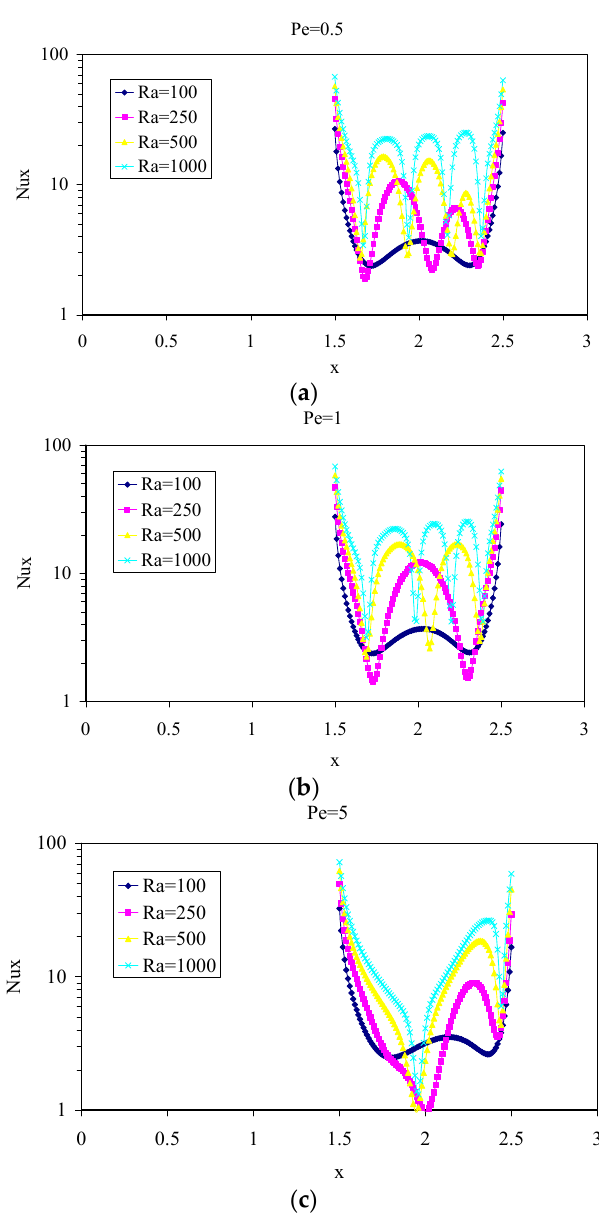
Figure 7 Variation of local Nusselt number along the channel ( c = 0.66), ( a ) Pe = 0.5, ( b ) Pe = 1, ( c ) Pe = 5